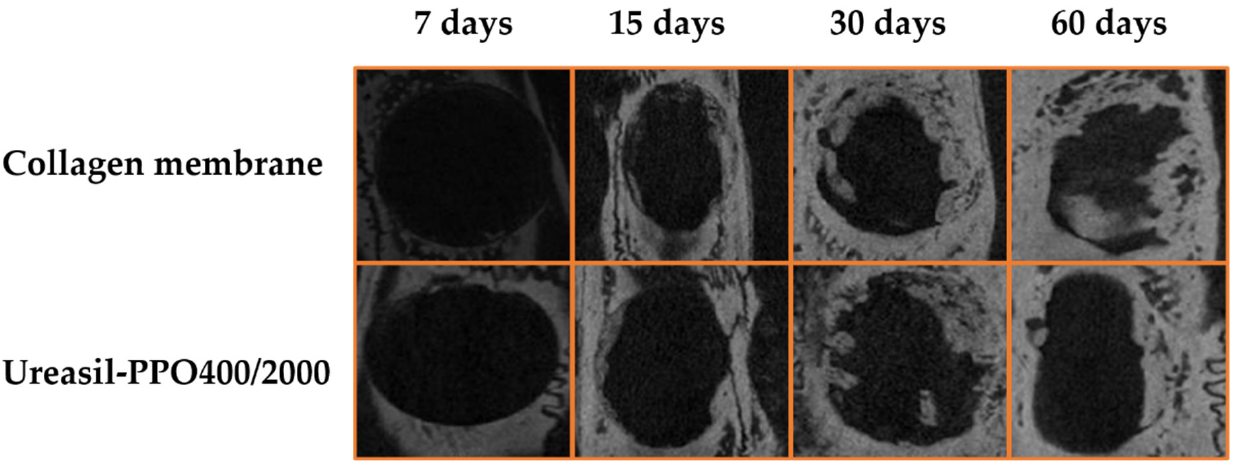
Figure 7. Photomicrotomography of the bone defects containing the commercial membrane and u-POP400/2000 membrane.